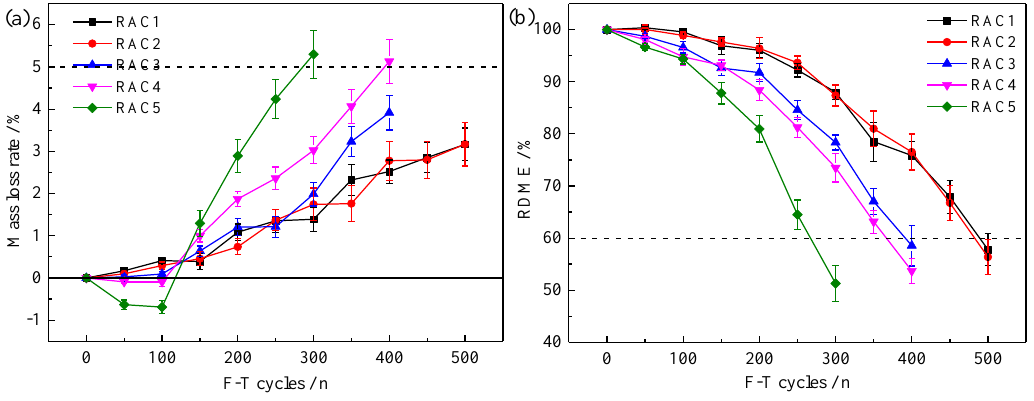
Figure 10. The variations of MLR ( a ) and RDME ( b ) of RAC- i.